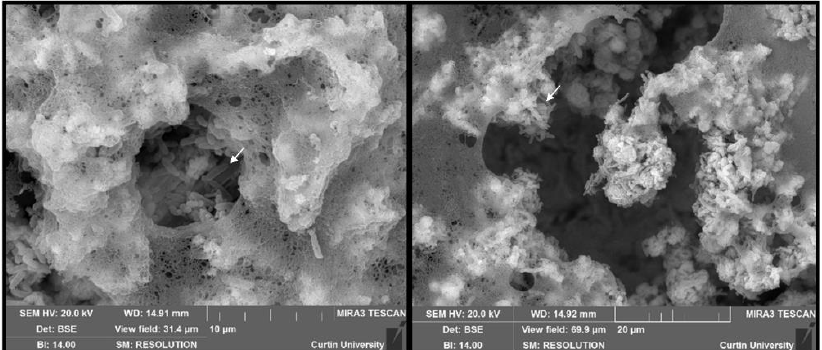
Figure 4. Scanning electron micrographs captured from 2-week-old biofilms showing a net-like structure within EPSs. Structures resembling bacterial cells are also evident in the samples.